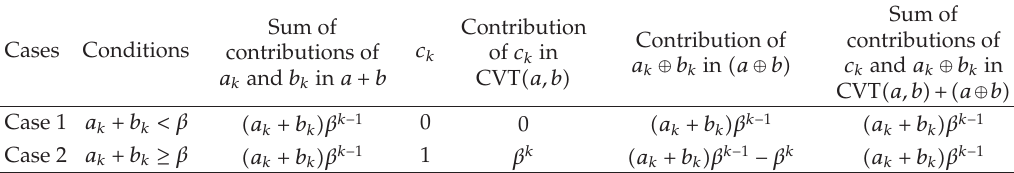
Table 2: Shows the contributions in calculating the sum for two possible cases.